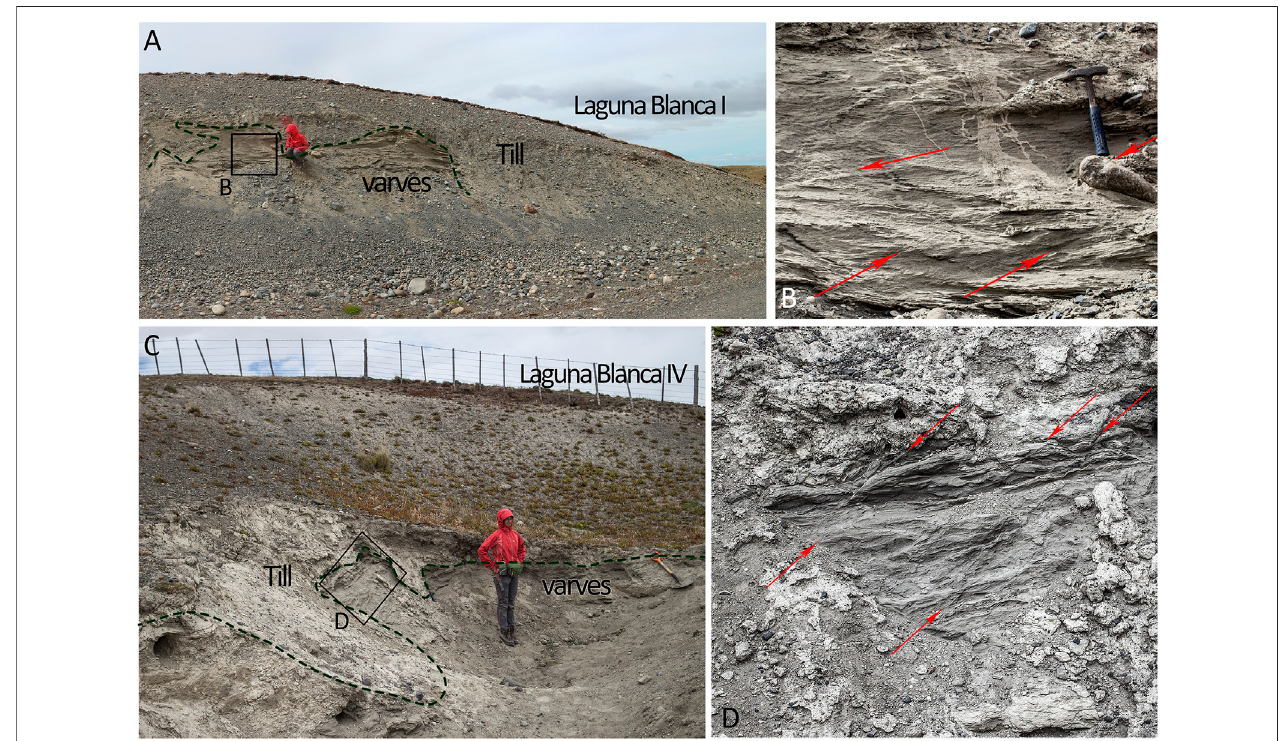
FIGURE 5 | Cut pro fi le from LB moraines, showing lacustrine sediments overlain by till. (A,B) . LB I. (C,D) . LB IV. The sediments have climbing ripple cross- lamination structure. The sediments show evidence of brittle deformation indicated by red arrows.